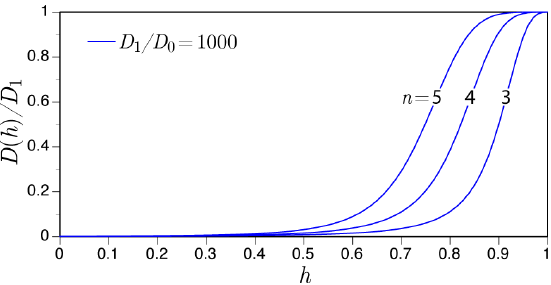
Figure 3. Dependence of hygral diffusivity on relative humidity according to Equation (17) with ψ ( T ) =